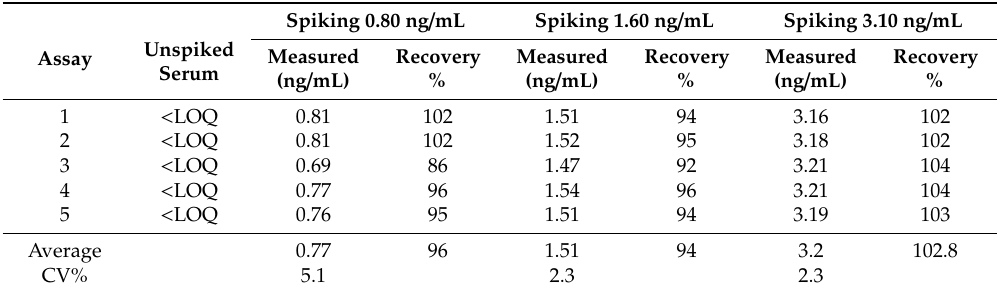
Table 2. Intraday precision of the test with ZVNS1-spiked serum.